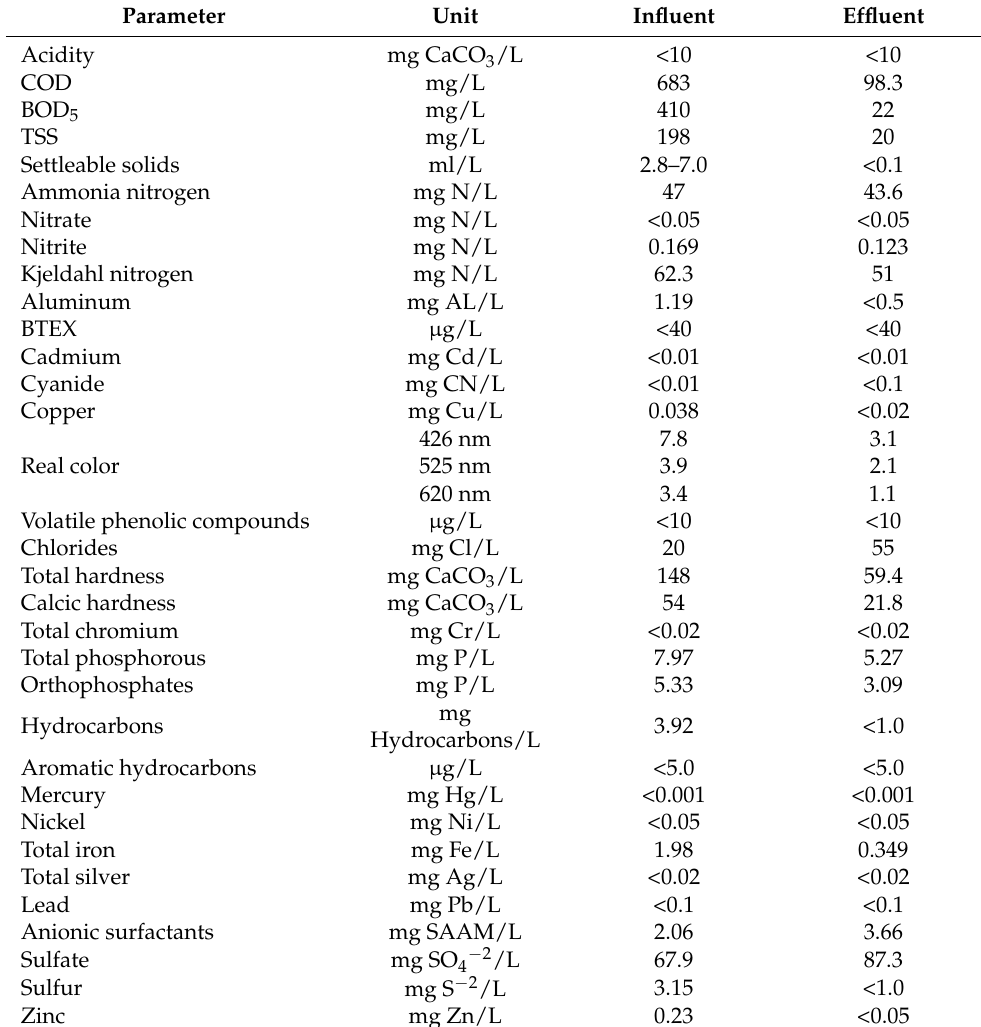
Table 7. Additional influent and effluent